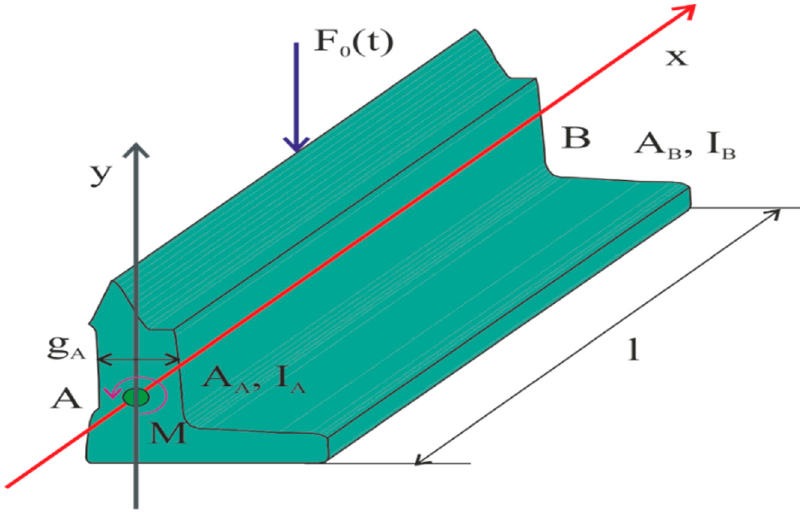
Figure 2. Parameters of the switch point.